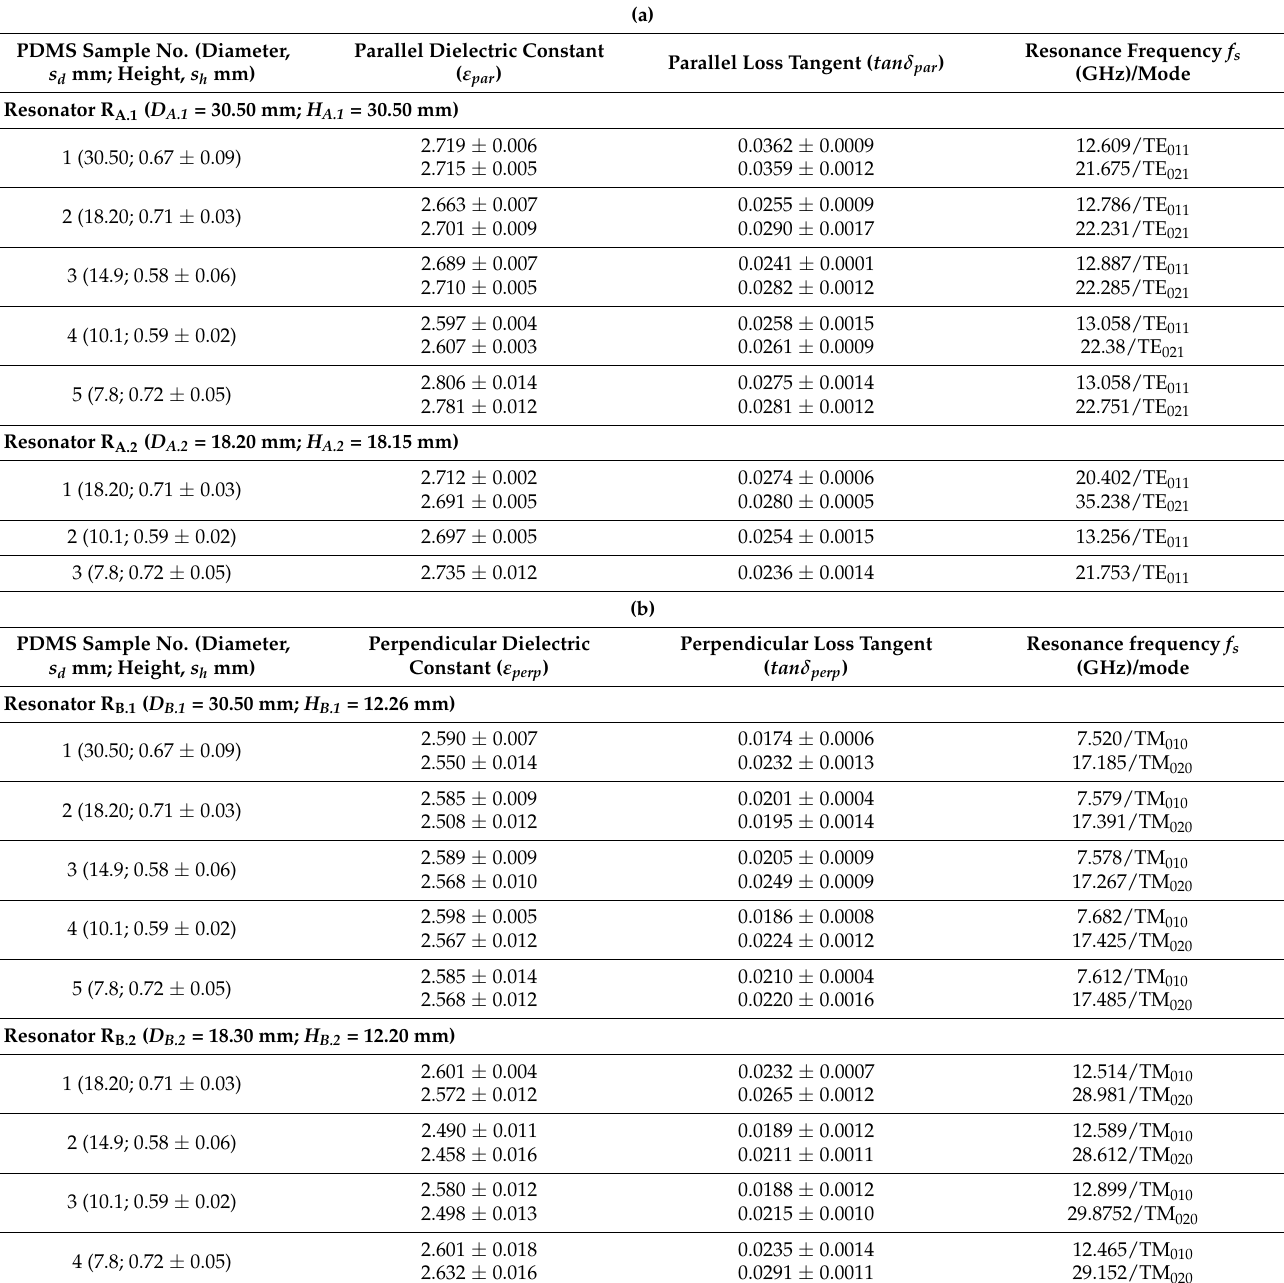
Table 2. Extracted dielectric parameters of PDMS ( a ) parallel values, and perpendicular values ( b ).